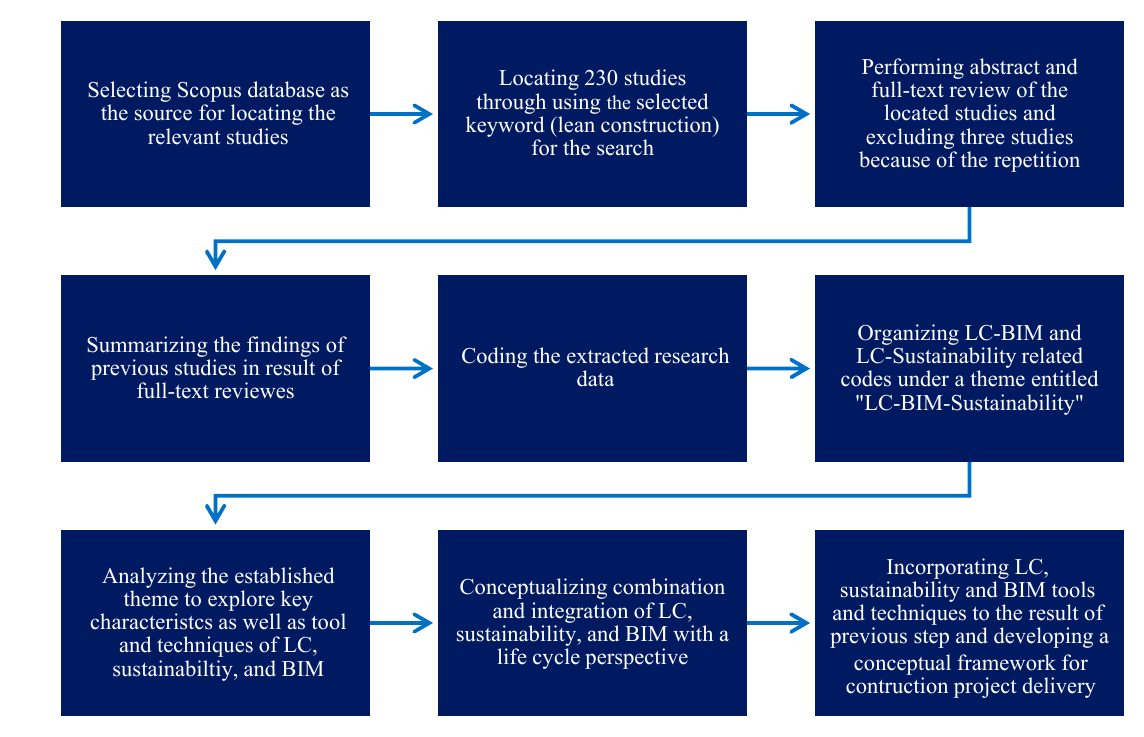
Figure 1. Further details of the data collection and analysis are explained in the following subsections.